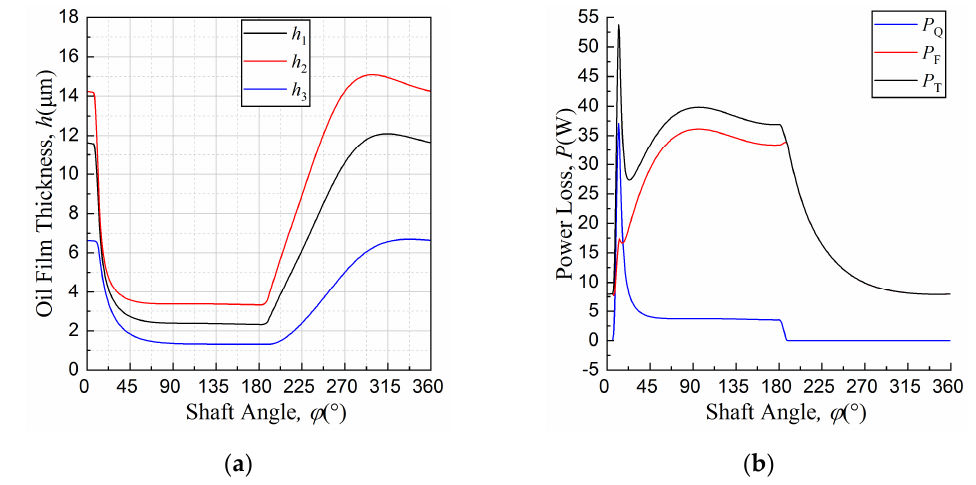
Figure 16. Simulation results of C1.2-3.5 under the selected working conditions, where ( a ) is the oil film thickness; ( b ) is the leakage, friction and total power loss of the slipper/swashplate interface.